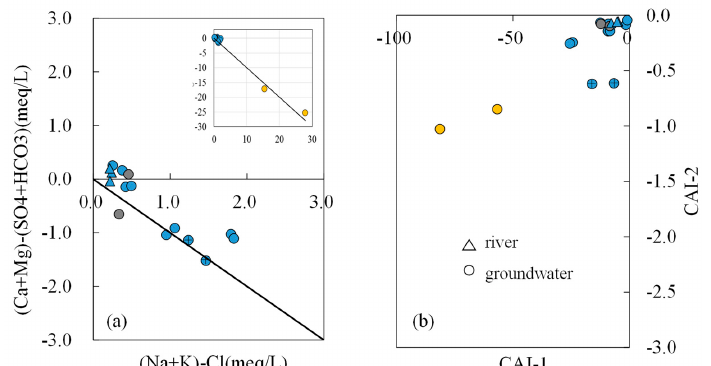
Figure 7. Relationships between ( a ) (Na + K) − Cl and (Ca + Mg) − (HCO 3 + SO 4 ); ( b ) CAI-1 and CAI-2 (CAI represents chloric alkali index). Triangles are river samples, circles are groundwater samples, and circles with a cross are the water samples at the borehole ZK. Yellow represents the spring at Zhanggu, grey represents the spring at Kemu, and blue represents the rest. The saturation states (shown in Figure 8) of the water samples with respect to halite, calcite, dolomite and gypsum were computed by the PHREEQC program to better investigate the minerals dissolved or precipitated in the groundwater system [2,3,11,43]. All water samples were under- saturated (SI < 0, SI is saturation index) with respect to halite and gypsum (Figure 8a,d), indicating that evaporates, silicates and sulfates were probably dissolved by water along the flow path. The SI values of most samples (excluding ZK, Zhanggu and Kemu) were greater than zero with respect to calcite and dolomite (Figure 8b,c), indicating that the groundwater with HCO 3 -Mg-Ca or HCO 3 -Ca- Mg type was easily oversaturated [5,45]. ZK with HCO 3 -Na-Mg type was undersaturated (SI < 0) with respect to calcite and dolomite, indicating that the stratum of this site probably had little calcite and